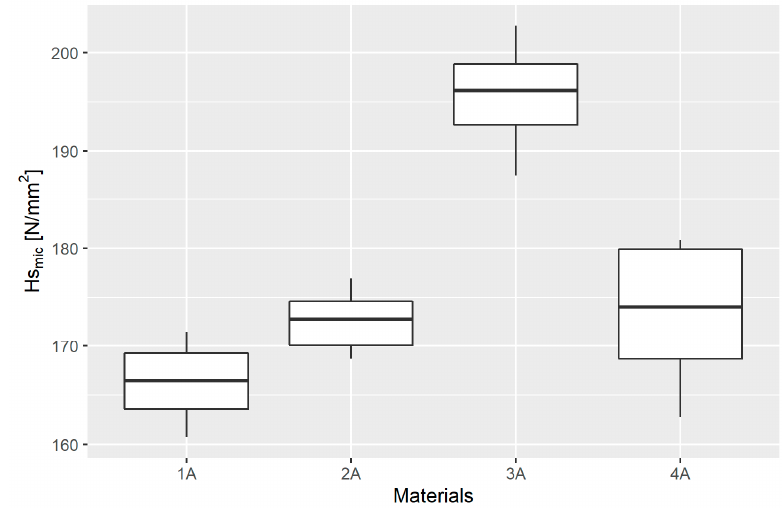
Figure 9. Box plot of scratch hardness results based on the measurements made using the optical microscope ( Hs mic ) in individual material groups.